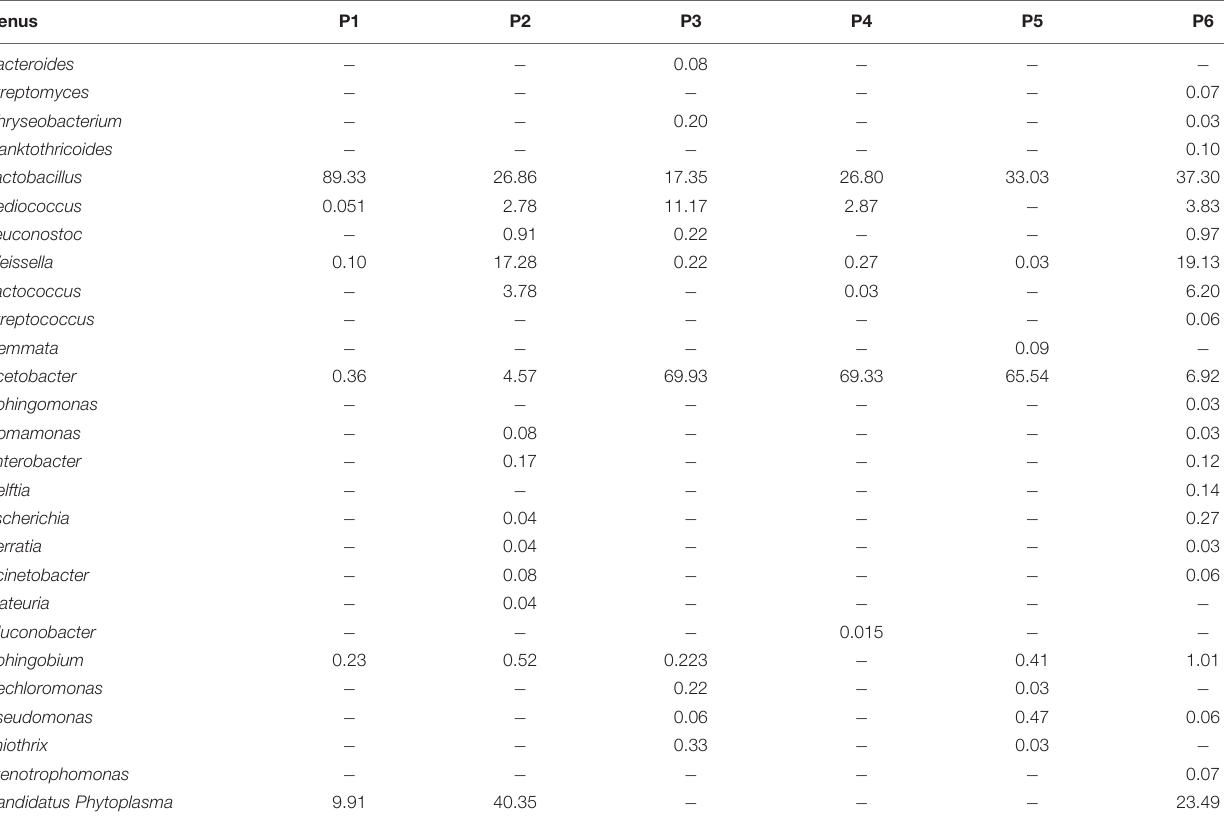
TABLE 5 | Bacterial community diversity in Masa Agria